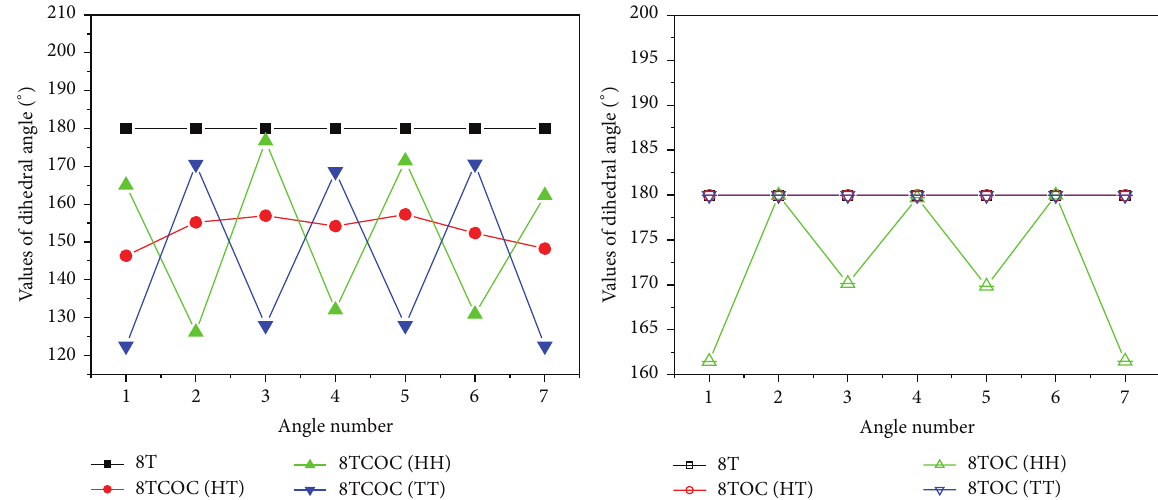
Figure 3: Optimized dihedral angle of 8T, 8TCOC (HH, HT, and TT), and 8TOC (HH, HT, and TT) in neutral states with the number of bonds, studied by B3LY/6-31G(d,p) level.